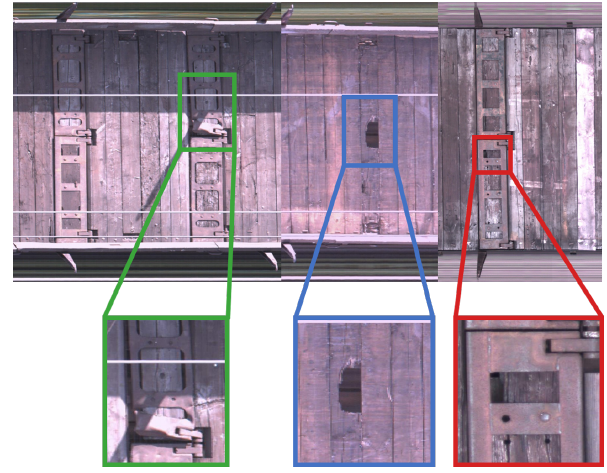
Figure 6. Top view image with wooden loadspace damage examples.